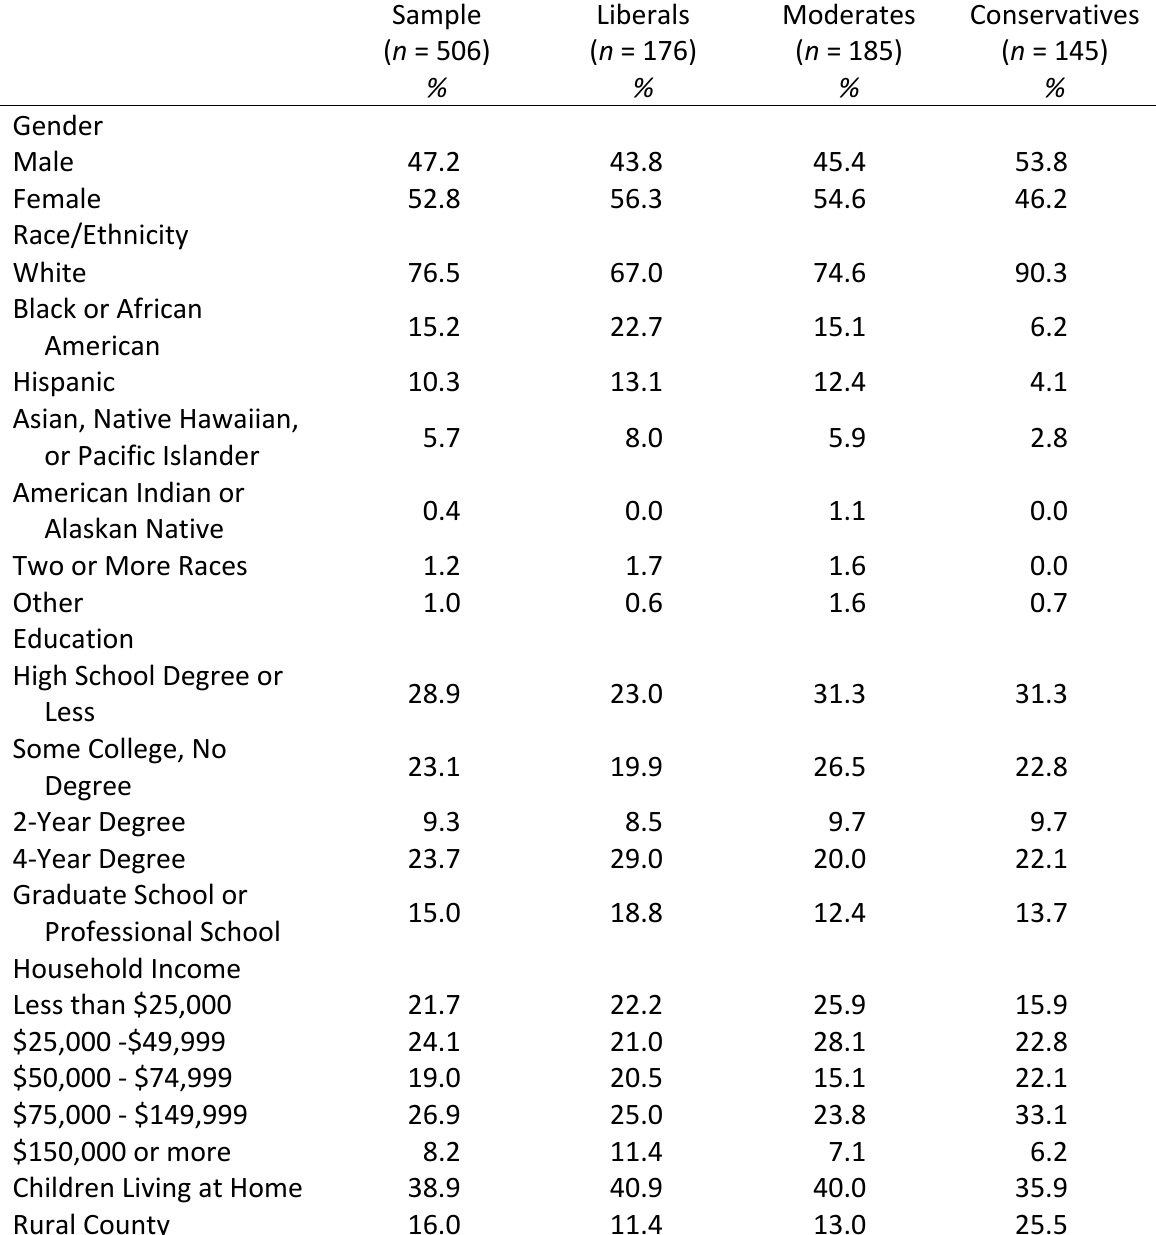
Description of Respondents Across Political Ideological